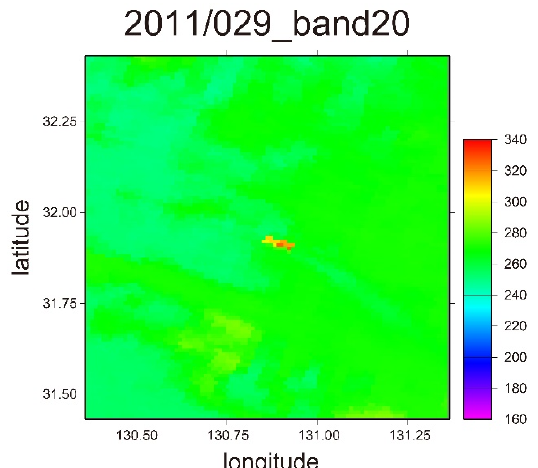
Figure 7. Example of a 2D distribution map of the brightness temperature of band 20. Brightness temperature is given by legend. A and B in Figure 2b corresponds to the locations near the summit crater and the region far from the summit, respectively. For Japan, LT = UT + 9 h. The nighttime images of Aqua have one day difference in date between LT and UT.